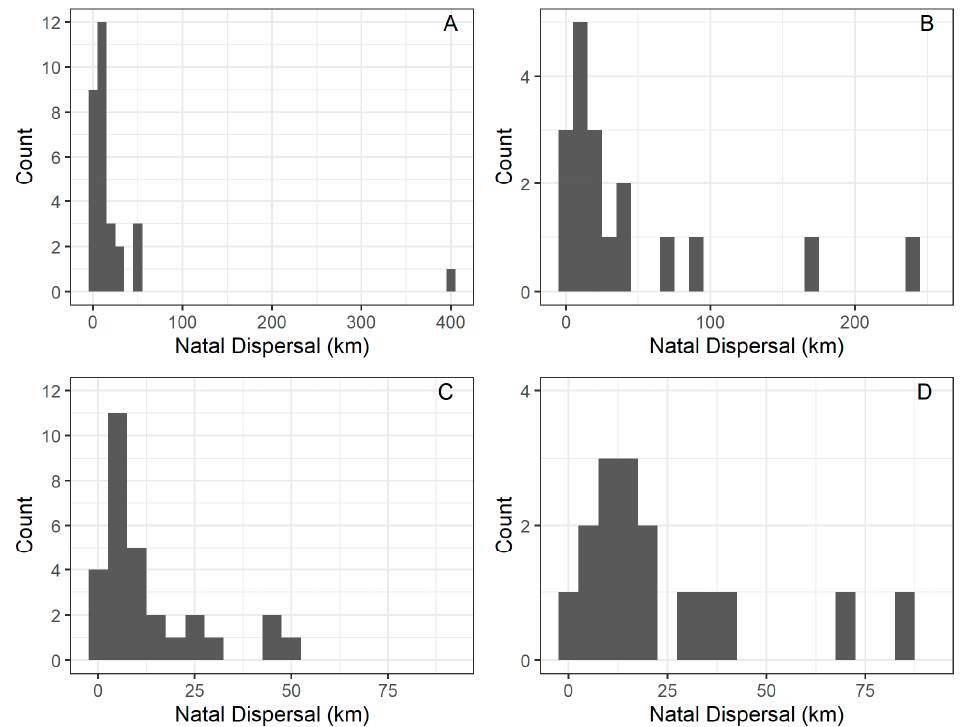
Figure 2. The top panels depicted the juvenile dispersal distance (km) of male ( A ) and female ( B ) Black-shouldered Kite ( Elanus caeruleus ) studied in southwestern Spain. The bottom panels depicted the juvenile dispersal distance (km) of male ( C ) and female ( D ) after excluding one male and two females that dispersed further than 100 km from their natal site.